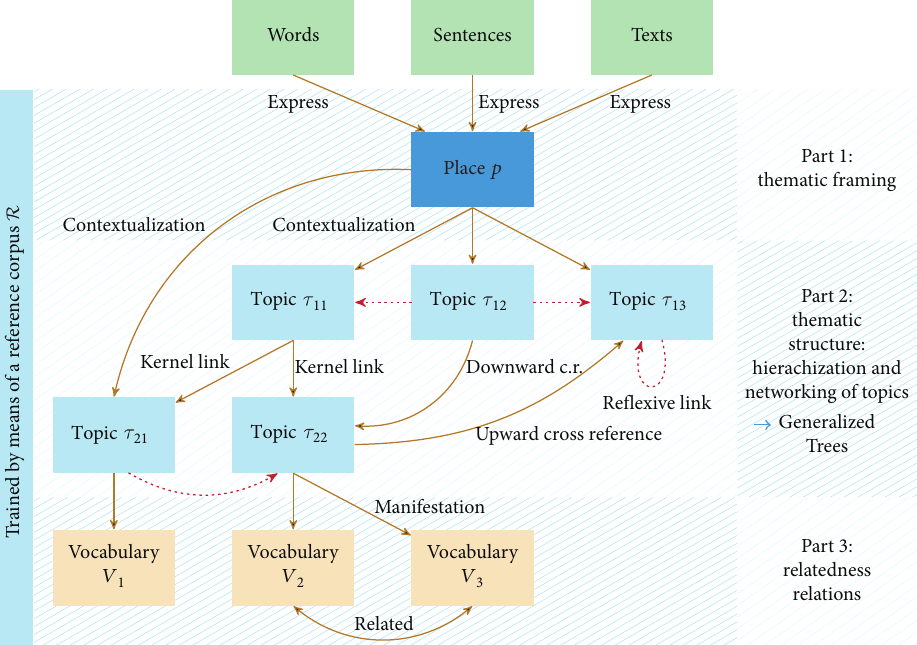
Figure 2: Schema of mapping texts onto hierarchically organized topic networks: words, sentences, and texts describing a certain thematic frame (e.g., a place as the central topic of a city wiki) are mapped onto a topic hierarchy as an example of a so-called generalized tree [56, 57]. Based on kernel links of thematic specialization, the topics are organized hierarchically, whereby this organization is superimposed by up- and downward cross-references. Dashed links are inferred as a result of modeling the thematic networking of input words, sentences, or texts. As we assume that the underlying topic model has been trained by means of a reference corpus R (see Definition 2), each topic is associated with a distribution of lexical elements of R that are preferably used to manifest this topic (see the types v and w in relation to the topics α and β in Figure 1). This preference relation may be extended to higher-level units such as